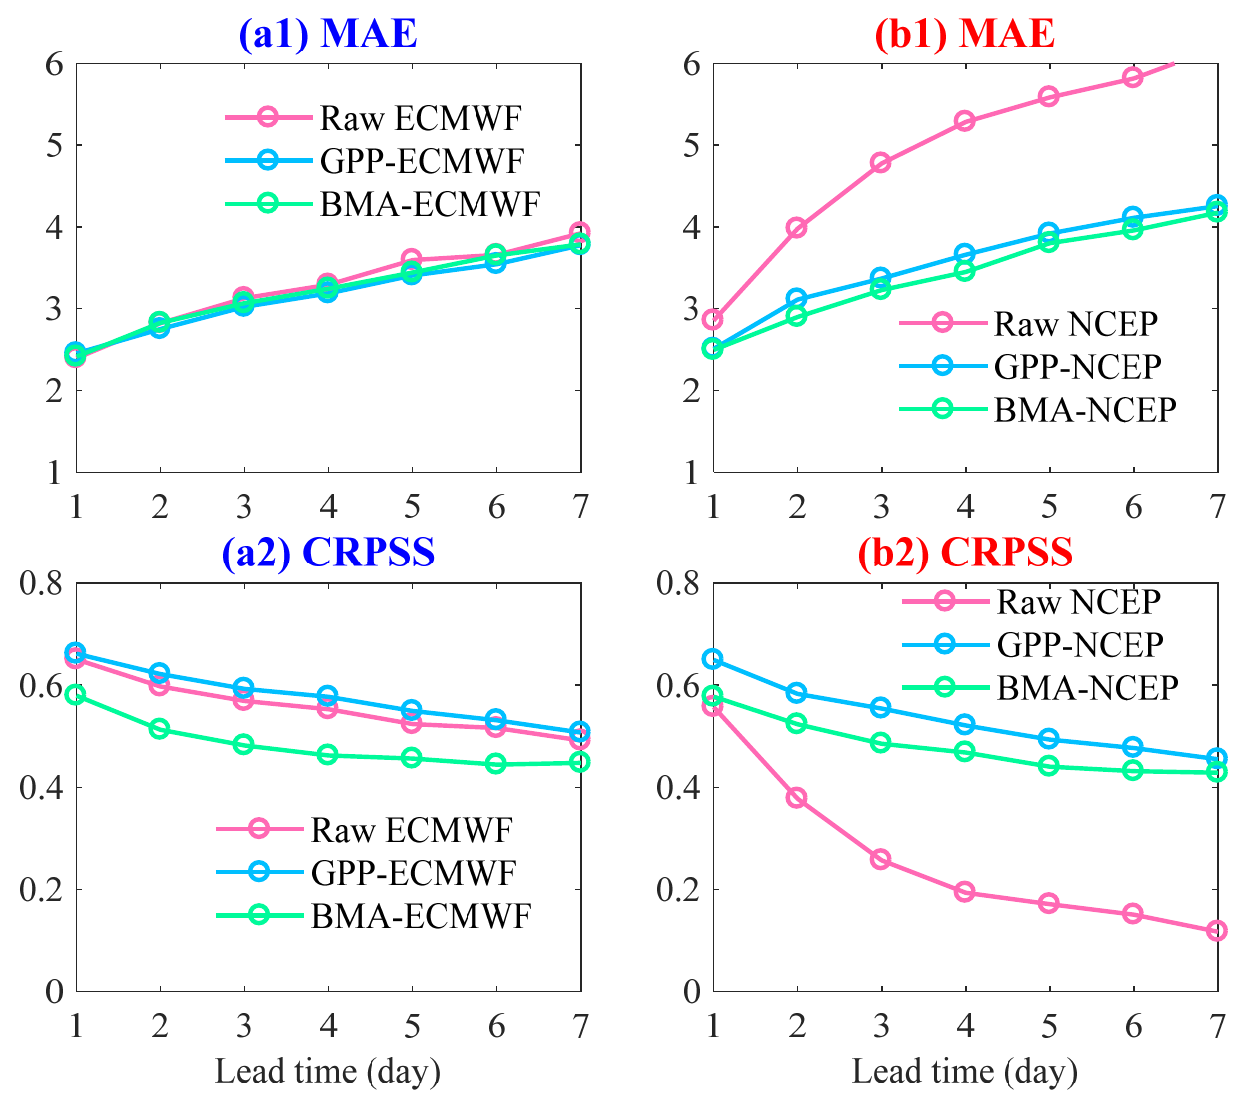
Figure 4. Line chart of evaluation indexes for ensemble precipitation forecasts by raw and postpro- cessed ECMWF ( a1 , a2 ) and NCEP ( b1 , b2 ).